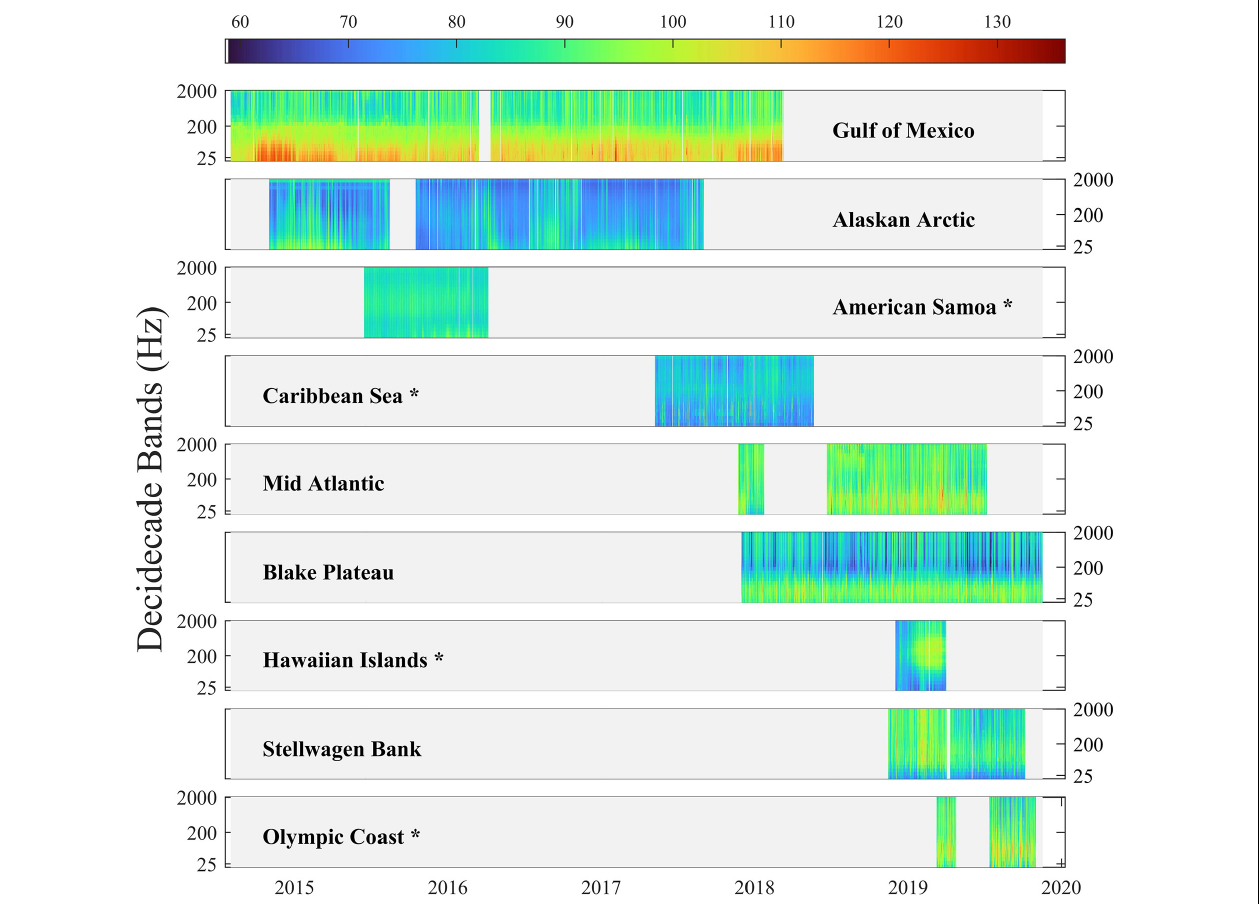
FIGURE 2 | Temporal coverage of acoustic recordings for the nine sites. Spectrograms depict the sound pressure level (dB re 1 µ Pa 2 ) of each hourly decidecade band by site. The frequency range is limited from 25 to 2,000 Hz, which reflects the common frequencies across all recordings. *Indicates a shallow water site. Note the y-scale represents decidecade bands and is